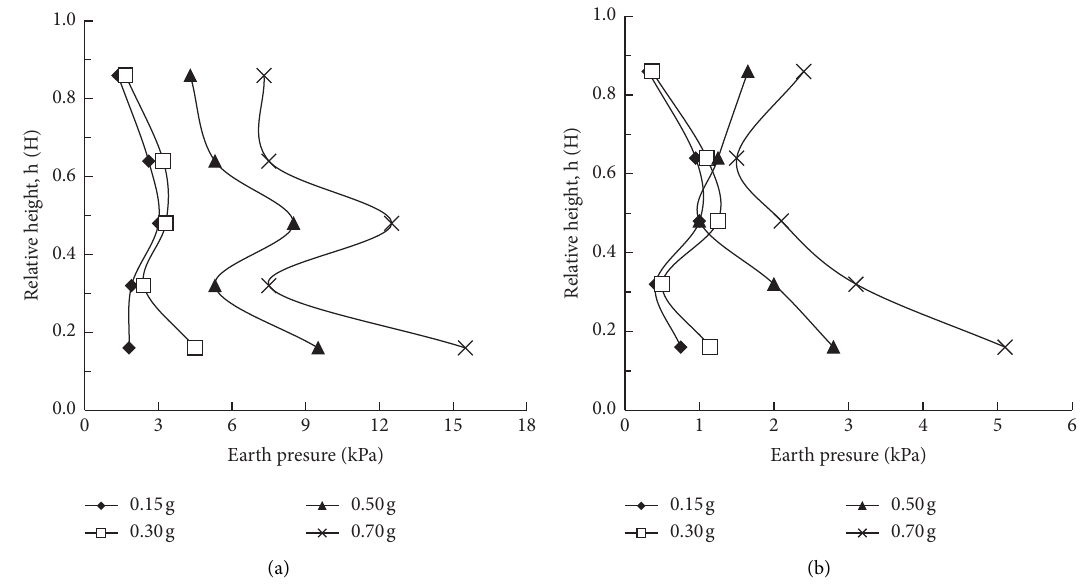
Figure 13: Lateral earth pressure acting on the back of (a) the pile B and (b) Pile A under the El Centro earthquake excitations.